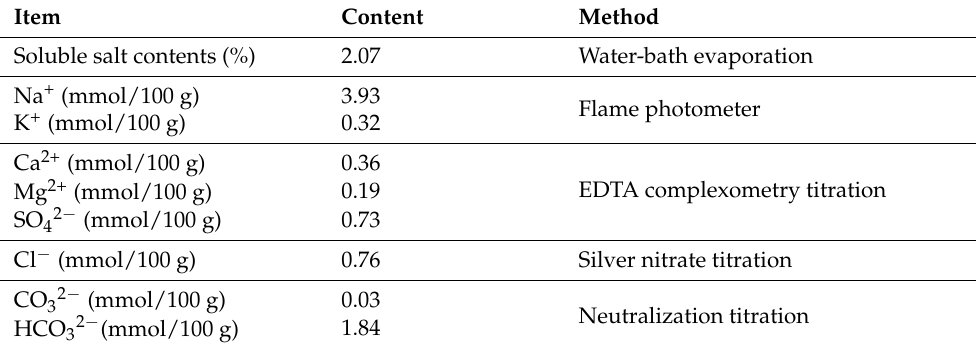
Table 3. Soluble salt contents of natural saline